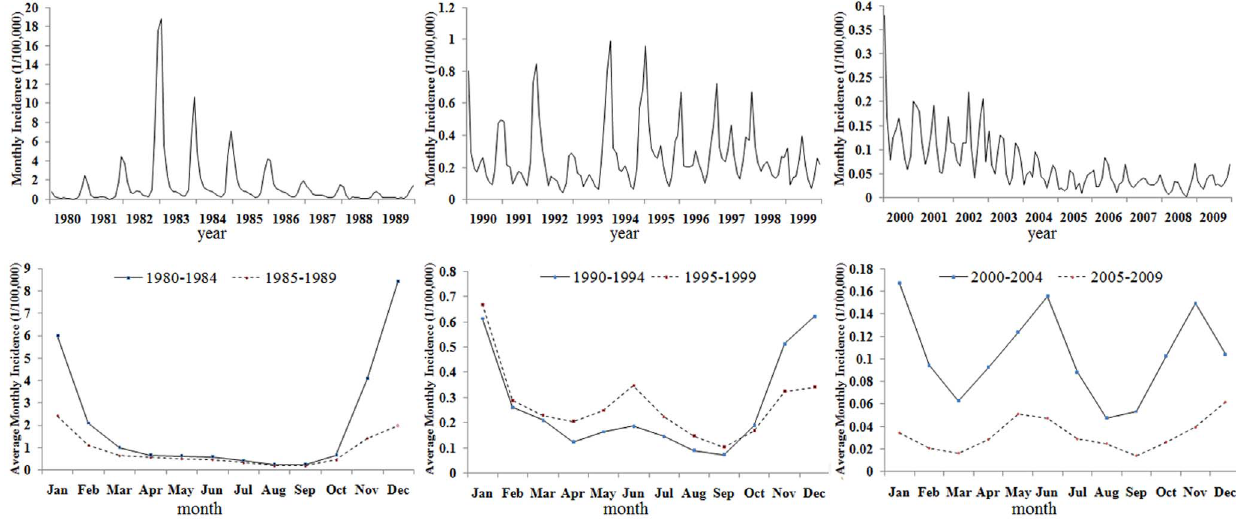
Figure 5. Temporal distribution patterns of HFRS incidence in Hubei Province. (A) Monthly epidemic curve of HFRS incidence for three decades. (B) Average monthly epidemic curve of HRFS cases every five